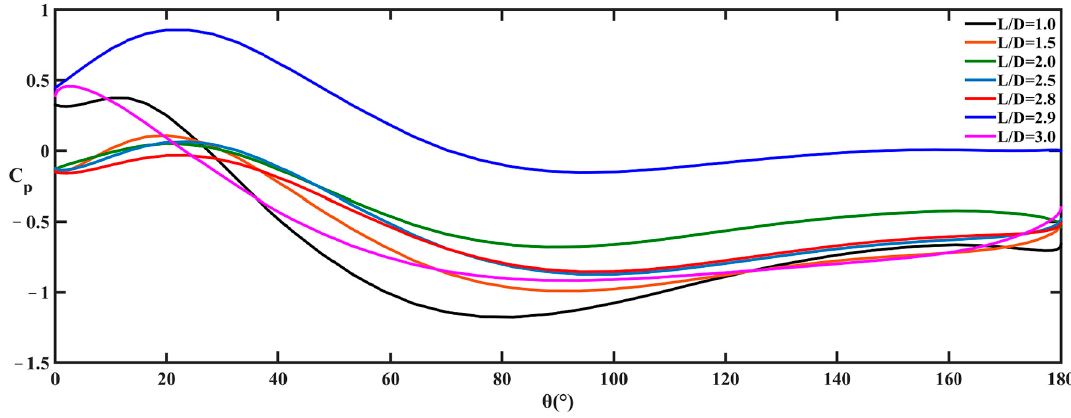
ffi cient at the surface of the Figure 6. Pressure coefficient at the surface of the cylinder. Figure 6. Pressure coe Figure 6. Pressure coefficient at the surface of the cylinder.